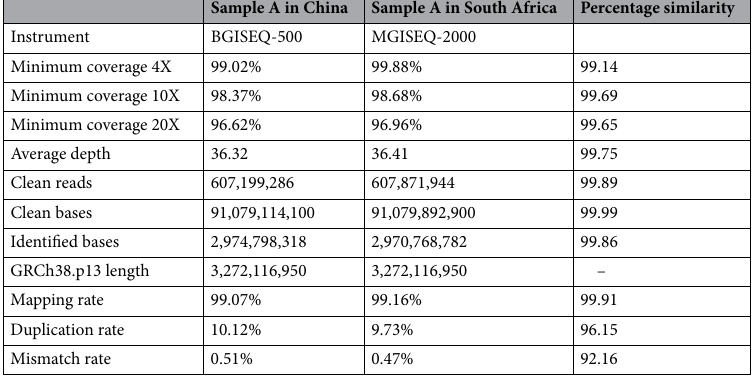
Table 2. Comparative analysis of MGISEQ-2000 in South Africa with that of BGISEQ-500 at BGI.